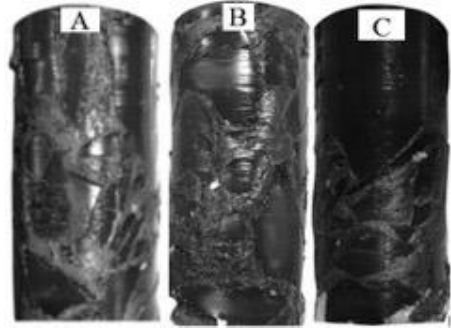
Figure 6. The grouted gangue specimens having grout proportions of ( A ) 6%, ( B ) 9%, and ( C ) 13%.